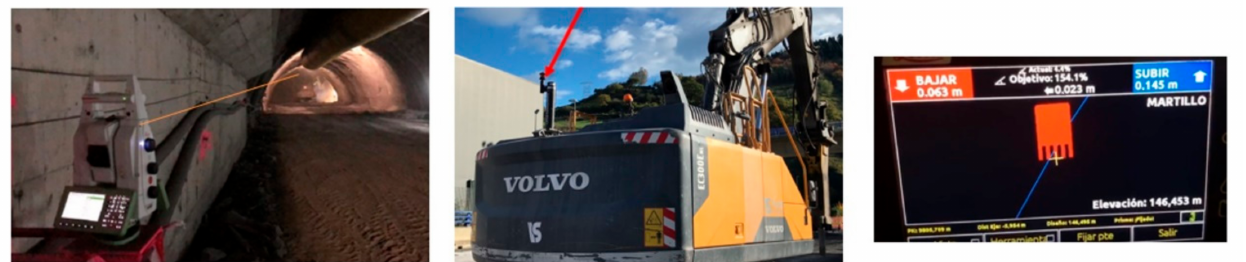
Figure 15. Example of 3D machinery positioning inside the tunnel. ( Left ) Location of robotized station. ( Centre ) Situation of receiver on backhoe. ( Right ) View in backhoe operator